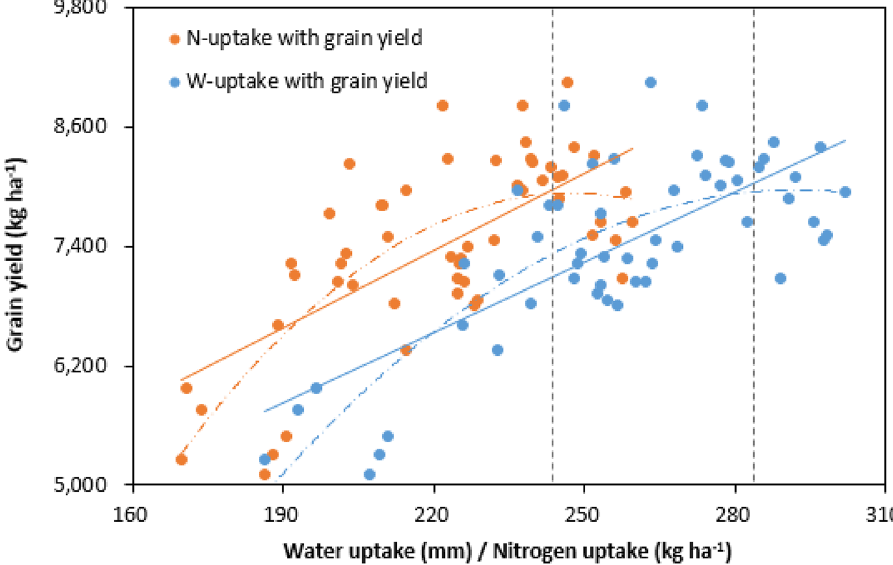
Figure 7. The relationship between water uptake and grain yield (blue circles and lines) and nitrogen uptake and grain yield (orange circles and lines) of spring wheat during the growing season in 2016–2018. The dash lines indicate the values of water uptake or nitrogen uptake when grain yield reaches the highest in a quadratic function.